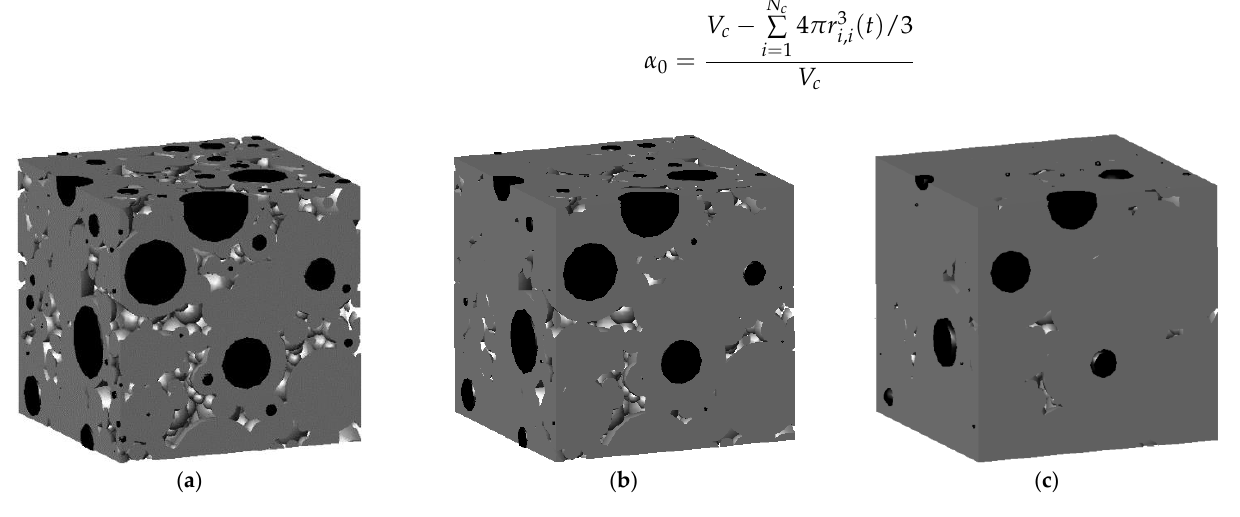
Figure 5. Comparison between the numerical results of hydration and experimental data [33]. 3. Simulation of Chloride Ion Diffusion Behavior The results of the hydration process revealed that cementite mainly consists of unhy- drated cement particles, gel, and pores. The pores are composed of gel pores, which are present in C-S-H, one of the components of gel products, and capillaries, the main path- way for chloride ion diffusion [12]. Therefore, we performed the simulation by simplify- ing cementite as a composite with a solid phase and a capillary phase. According to Kim and Torquato [29,34], cementite is a homogeneous matrix that has a chlorine diffusion rate of D cp when Brownian motion is simulated. Thus, the Brownian particle can be dropped into the simulation cell at an initial position of o , and a sphere with radius R 0 can be established, as illustrated in Figure 6b. The average time